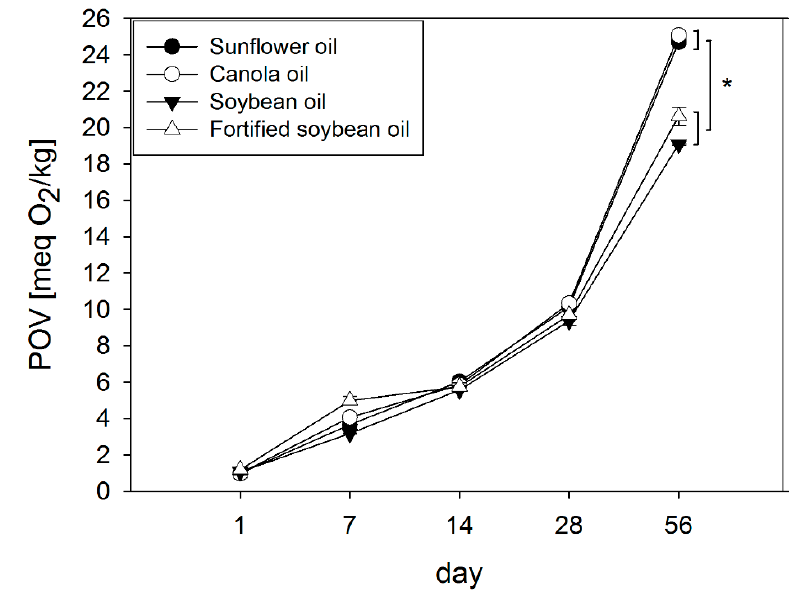
Figure 2. Changes of the peroxide values in four oil types (sunflower, canola, soybean oil, fortified soybean oil) stored at 22 °C in a 12 h light/dark cycle for 56 days. Data are represented as mean ± SD ( n = 4). Statistically significant differences between the different oil types on day 56 were analyzed using one-way ANOVA ( p ≤ 0.001) followed by Holm-Sidak post hoc test (* p < 0.05).